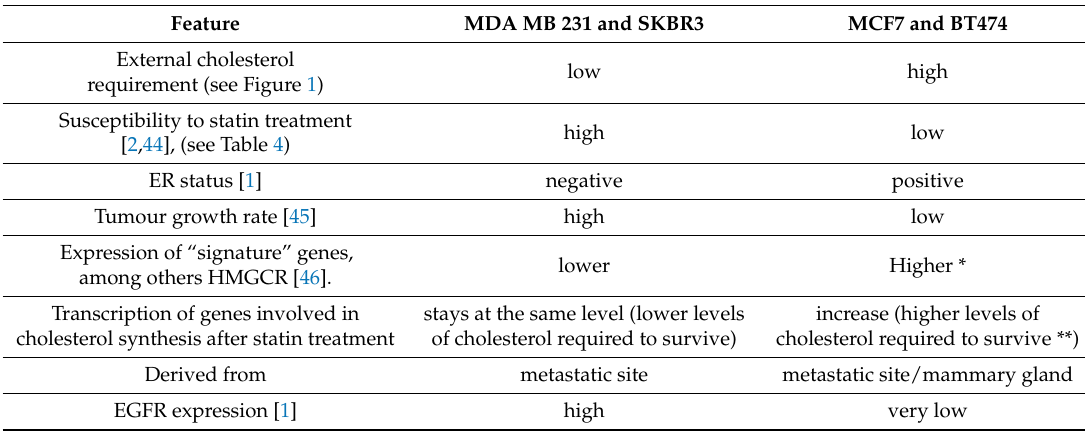
Table 5. Comparison of cells that are sensitive or less sensitive to cholesterol